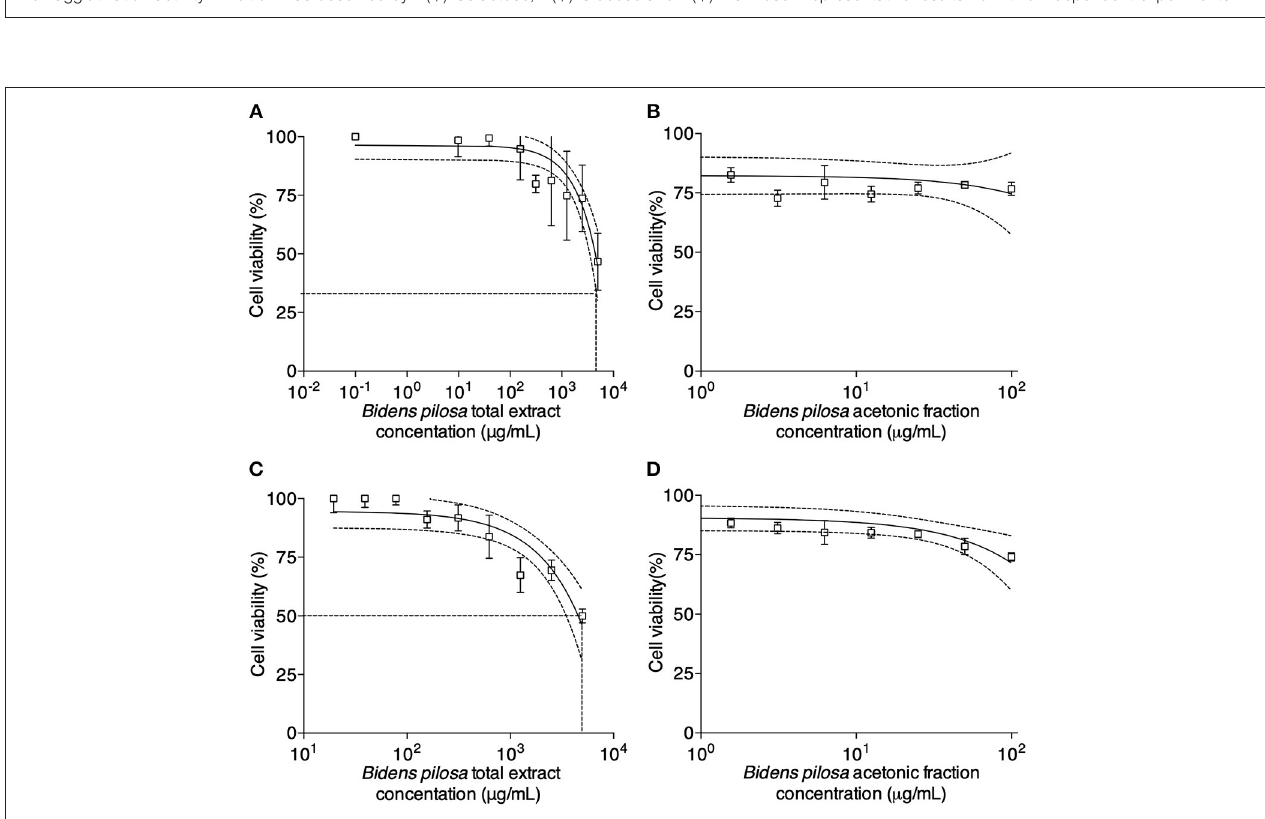
FIGURE 3 | In vitro cytotoxicity activity determined by MTT assay for HeLa and peritoneal cells from C57BL/6 mice. HeLa cells were cultured in 96-well plates in the absence (control) or presence of different concentrations of (A) Bidens pilosa total extract (from 5,000 to 9.8 µ g/mL) or (B) Bidens pilosa acetonic fraction (from 100 to 0.8 µ g/mL) for 24h. Results are expressed as percentage of viable cells compared to control. Peritoneal cells were cultured in 96-well plates in the absence (control) or presence of different concentrations of (C) Bidens pilosa total extract (from 5,000 to 9.8 µ g/mL) or (D) Bidens pilosa acetonic fraction (from 100 to 0.8 µ g/mL) for 48h. Results are expressed as percentage of viable cells compared to control. Values are representative from three independent experiments, indicating mean ± SD.